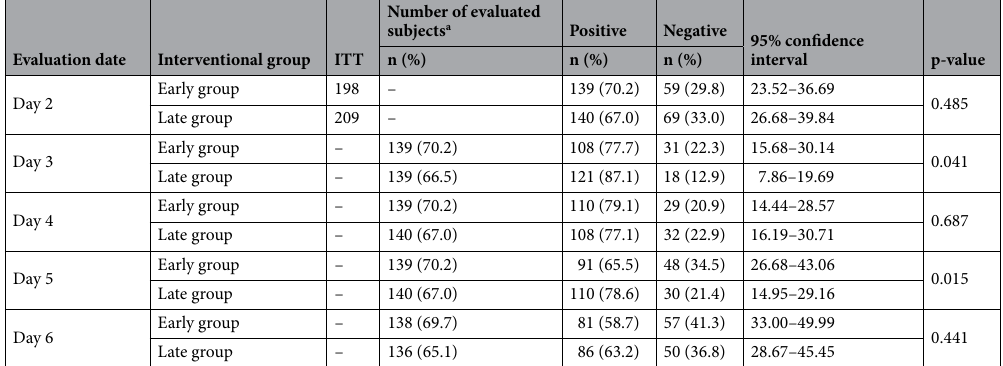
Table 3. Changes in the clearance rate of SARS-CoV-2 in saliva. a Subjects who were positive for COVID-19 on day 2.